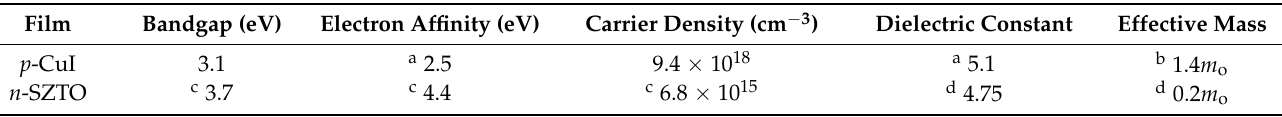
including CuI [2,12], SZTO [13,22], IGZO [8,24], BaSnO 3 [12,25], and ITO [26]. Based on aligned at the vacuum energy level E vac = 0. The top (red) and bottom (blue) columns present conduction and valance bands, respectively. In order to investigate the energy band diagram of the annealed CuI (140 nm)/SZTO diode shown in Figure 5b, first of all, several energies such as E vac , valance band maximum ( E V ), and conduction band minimum ( E C ) are determined from Figure 5a. Subsequently, the Fermi energy level ( E F ) is calculated from the Anderson diode model for heterojunction [27]; various input parameters of valance band maximum E V , conduction band minimum E C [2,13], dielectric constant [2,22], and effective masses [22,28] of both CuI and SZTO are adopted from the literature. E g and n of SZTO are estimated from our previous work [13], while E g and p of CuI are obtained in this work. Basic parameters and related references are summarized in Table 2. Table 2. Input parameters of the Anderson heterojunction diode model for the annealed p -CuI/ n -SiZnSnO (SZTO) diode where m o is the electron mass. Film Bandgap (eV) Electron Affinity (eV) Carrier Density (cm − 3 ) Dielectric Constant Effective